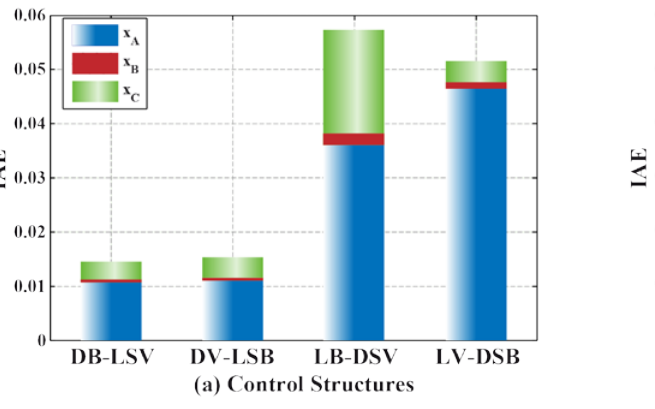
Figure 9. Comparison of the performance of the control structures in terms of the Integral of Absolute Error (IAE) for a disturbance of ( a ) +10% in the feed flow rate and ( b ) +10% in the light component